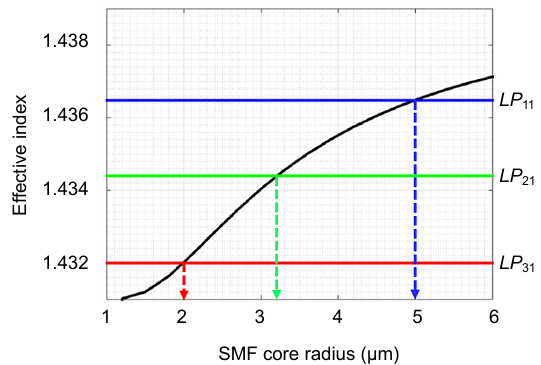
Fig. 1 | Effective indices of different modes in the SMF ( LP 01 mode) and MMF ( LP l 1 modes) at a wavelength of 1550 nm . The black curve shows the effective index of the fundamental mode in the SMF as a function of the core radius. The horizontal lines show the effective indices of the LP l 1 modes in the MMF